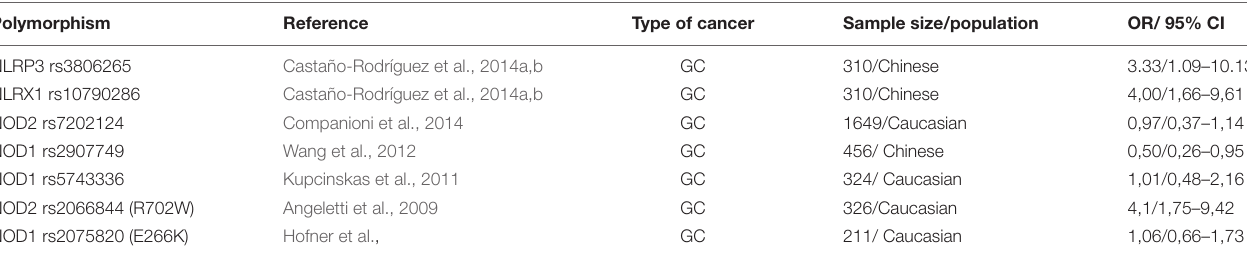
TABLE 1B | Genetic polymorphisms in the NOD-like receptor signaling pathway that have been studied in relation to gastric cancer.